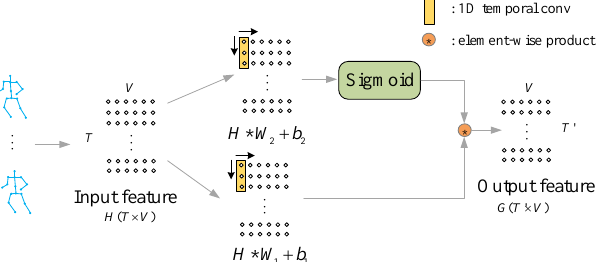
Figure 3. The illustration of gated convolution operation. The feature of skeleton sequences will be normalized as the matrixes H ( T × V ) . These two 1D temporal convolutions (TC) have the same kernel size k . TC followed by the sigmoid function computes the value of gate mechanism. The output feature of another TC is multiplied by